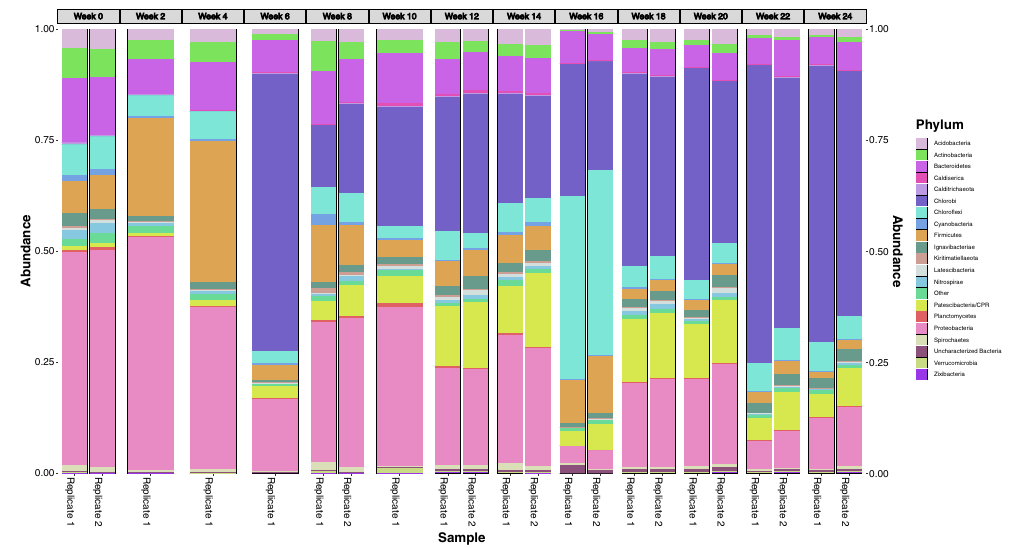
Fig. 5 Microbial community composition and abundance measured using analyses of 16S rRNA Amplicons. Stacked bar graph describing the community composition of microbes growing on the carbon composite material across all samples. Weeks with two bars had duplicate DNA samples extracted and, therefore, had duplicate 16S community abundance plots generated for